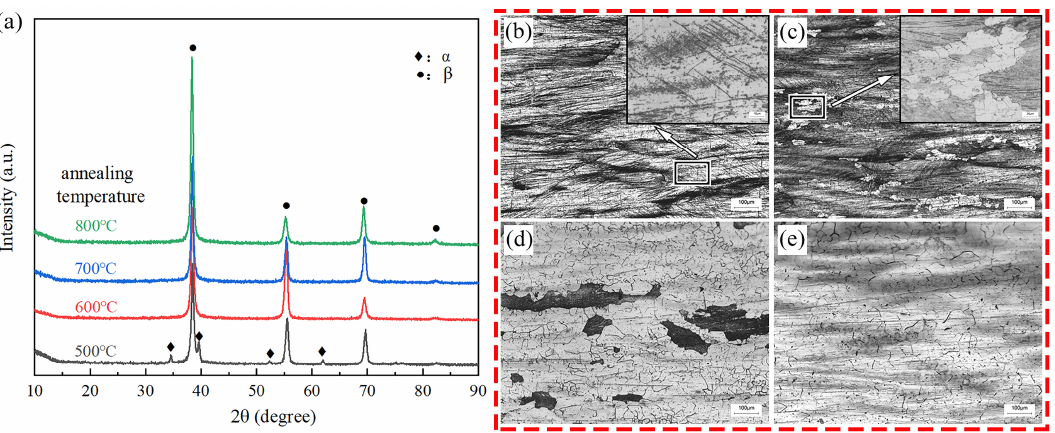
Figure 1. XRD diagram and OM diagram after annealing: ( a ) XRD diagram; ( b ) annealed at 500 °C; ( c ) annealed at 600 °C; ( d ) annealed at 700 °C; ( e ) annealed at 800 °C.